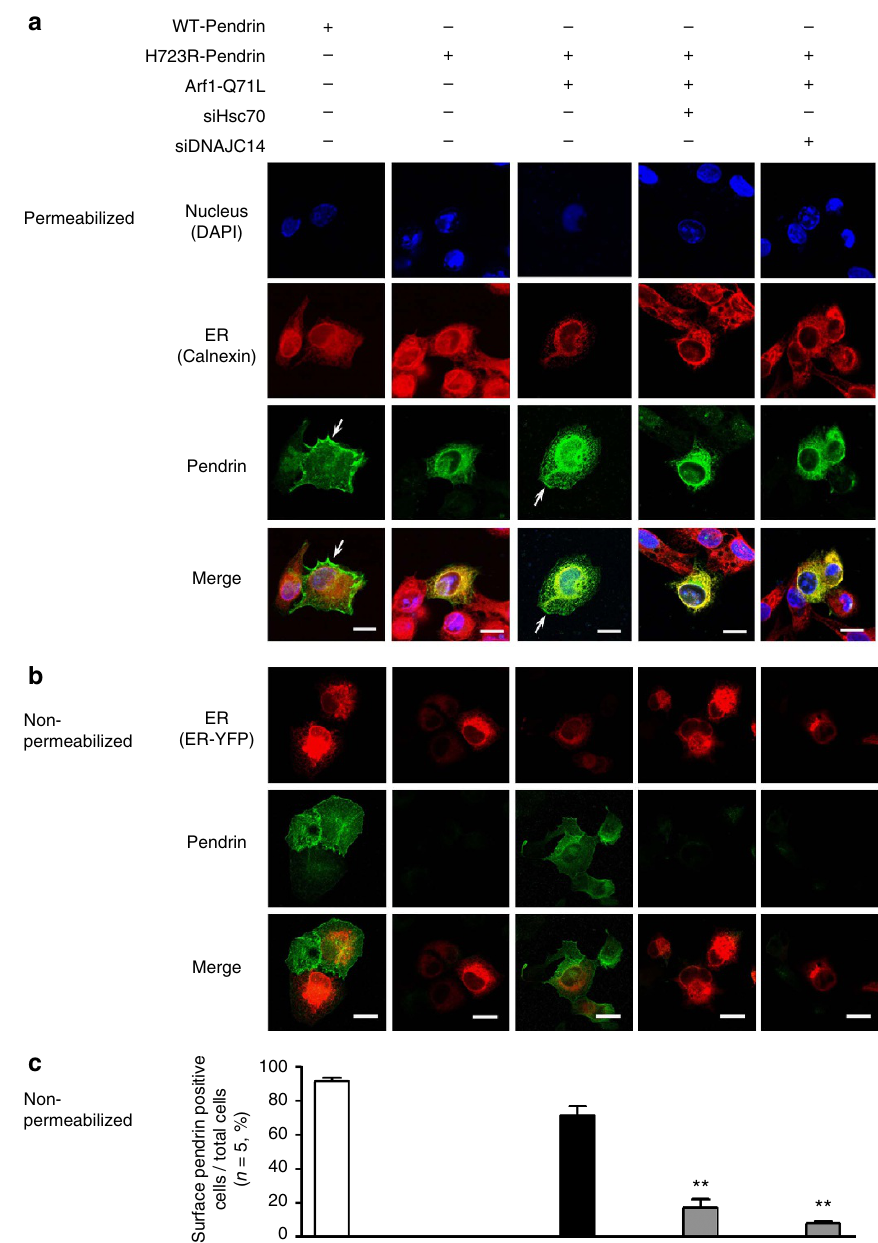
Figure 6 | Knockdown of Hsc70 and DNAJ14 inhibits the cell-surface expression H723R-pendrin induced by Arf1-Q71L. ( a ) Cellular localization of pendrin was examined in PANC-1 cells permeabilized with ethanol and acetone. Cells stained for WT- and H723R-pendrin were co-stained for the ER marker protein calnexin. Arrows indicate the cell-surface expression of WT- or H723R-pendrin. Nuclei were counterstained with 4 0 ,6-diamidino-2- phenylindole (DAPI). Scale bar, 20 m m. ( b , c ) Cell-surface expression of WT- and H723R-pendrin was examined in non-permeabilized PANC-1 cells (4% formaldehyde fixation) using antibodies against the extracellular N terminus of pendrin 8 (Abcam, ab66702). The plasmid encoding the ER marker protein ER-yellow fluorescent protein (YFP) was co-transfected. Arf1-Q71L induced the cell-surface expression of H723R-pendrin, which was blocked by siRNAs targeting Hsc70 and DNAJC14. Quantification of the ratio of cells expressing pendrin on the cell surface relative to total cells in five independent experiments is shown in c . Scale bar, 20 m m. ** P o 0.01 by one-way analysis of variance, difference from H723R-Pendrin þ Arf1-Q71L alone (lane 3), n ¼ colocalized with Hsc70 (Fig. 10a,b). The Hsc70-K71M and DNAJC14-H471Q mutations significantly inhibited the colocali- zation of Hsc70 and DNAJC14 (Fig. 10a,b). In an effort to identify the punctate structures, cells were immunostained for multiple markers of organelles and vesicles. Of these, over- expressed DNAJC14 clearly colocalized with Rab18, which is considered to be a marker of lipid droplets 24 (Supplementary Fig. 8). The association between DNAJC14 and Rab18-containing structures was also recapitulated on examination of endogenous